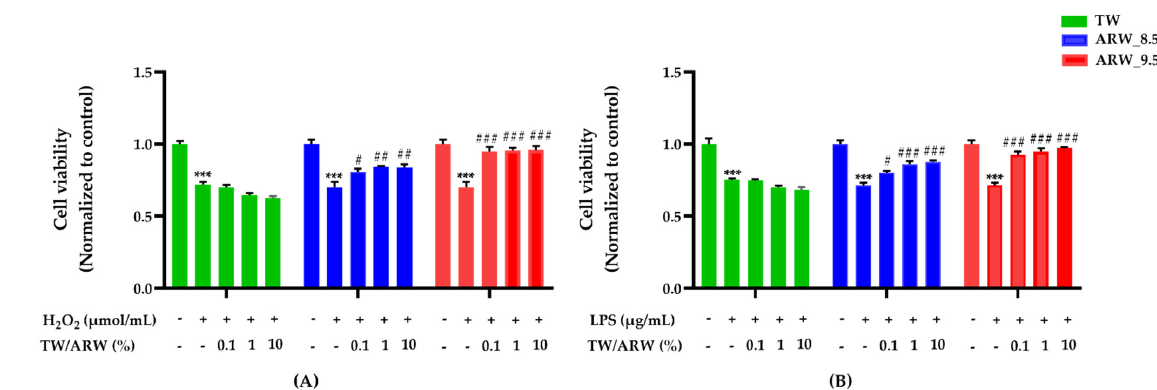
Figure 1. Effect of ARW_8.5 and ARW_9.5 on cell viability in H 2 O 2 − and LPS-induced RAW 264.7 murine macrophage cells. Cell toxicity was induced by H 2 O 2 (200 µmol/mL for 2 h) ( A ) and LPS (10 µg/mL for 24 h) ( B ), and cells were treated with ARW (pH 8.5 and pH 9.5) at concentrations of 0.1%, 1%, and 10%. Data are expressed as the mean ± standard error of the mean (SEM) of the fold change relative to the control ( n = 3). Statistical significance was analyzed with two-way ANOVA. TW: tap water, ( − ): non-treatment, (+): treatment. ***, p < 0.001 vs. normal control; # , p < 0.05; ## , p < 0.01, and ### , p < 0.001 vs. Con/H 2 O 2 or Con/LPS. Abbreviations: Con, control; ARW, alkaline reduced water; TW, tap water; H 2 O 2 , hydrogen peroxide; LPS, lipopolysaccharide.